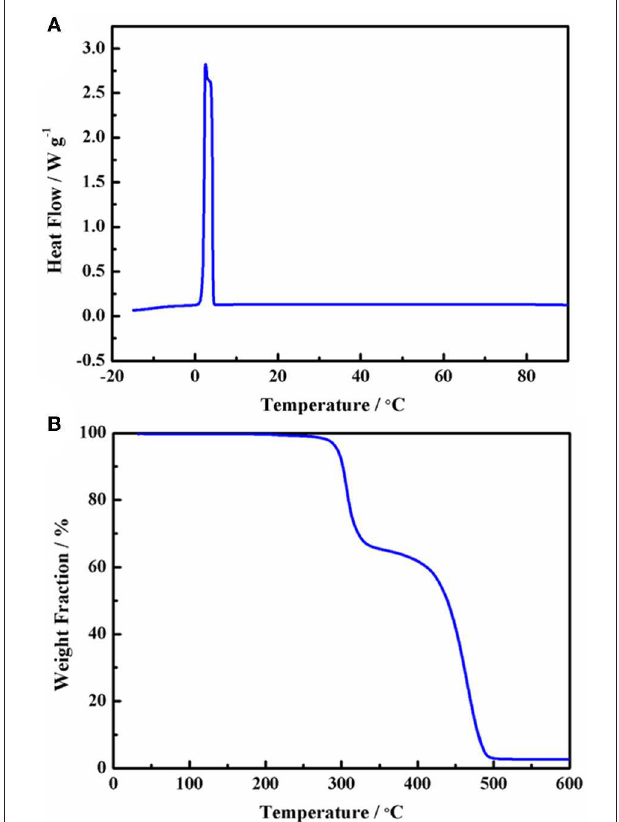
FIGURE 2 | DSC (A) and TGA (B) heating traces (5 ◦ C min − 1 ) of the Py 13